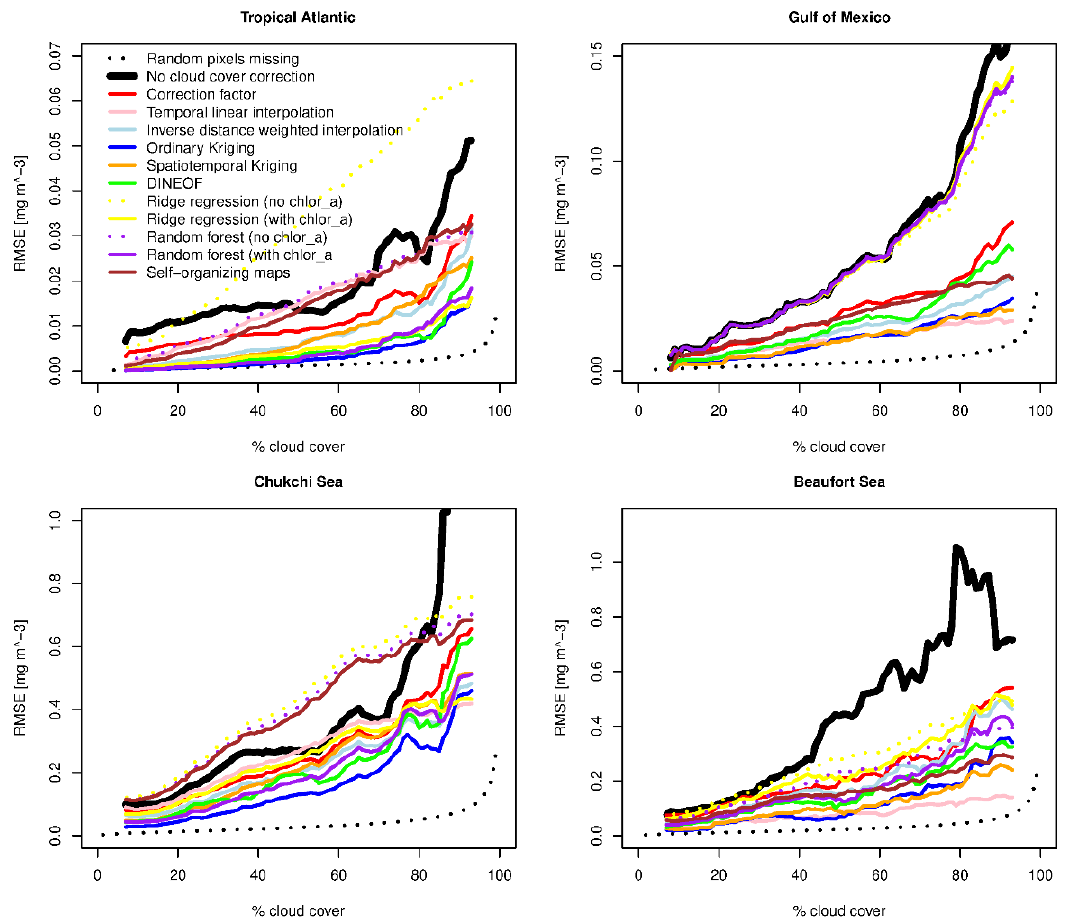
Figure 8. Running means of the mean error of the regional mean Chl a concentration ( RMSE mean ) as a function of cloud cover, calculated with and without prior cloud-filling.